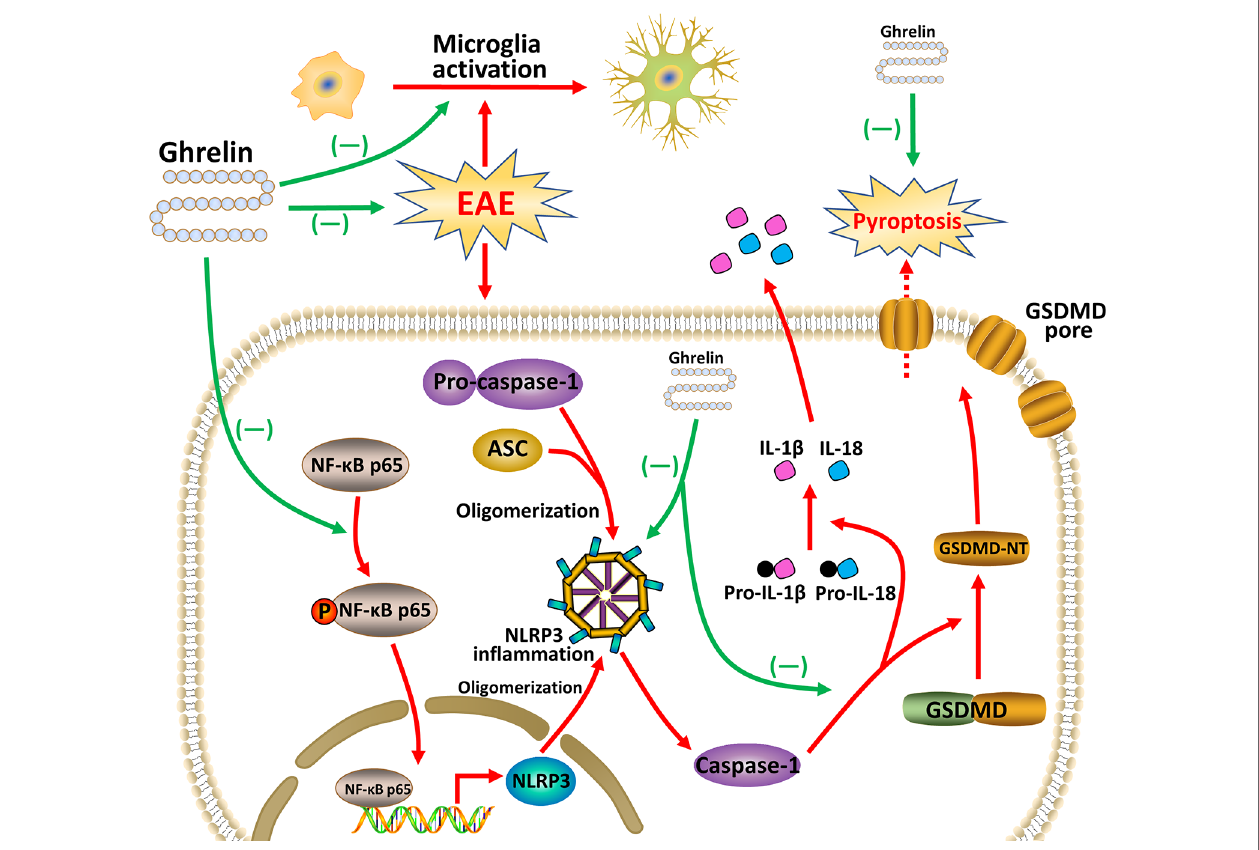
FIGURE 8 | Ghrelin attenuates neuroinflammation and demyelination in EAE involving the NLRP3 inflammasome signaling pathway and pyroptosis.